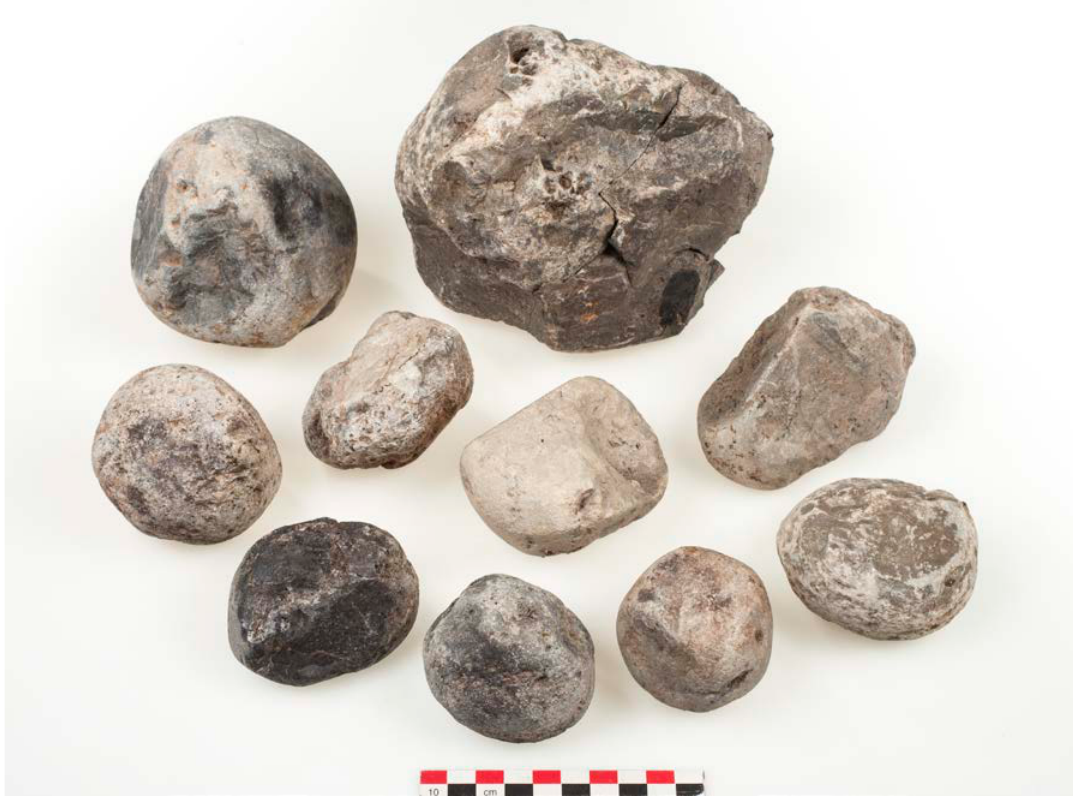
Figure 10. Examples of silicified limestone hammerstones (Photo: M. Delloul,